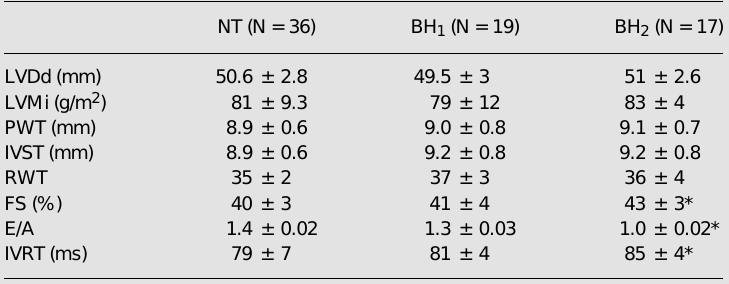
Table 4. Doppler echocardiographic values of normotensive (NT) and borderline hyper- tensive subjects with normal (BH 1 ) and elevated (BH 2 ) monitored blood pressure. NT (N = 36) BH 1 (N = 19) BH 2 (N = 17) LVDd (mm) 50.6 ± 2.8 49.5 ± 3 51 ± 2.6 LVMi (g/m 2 ) 81 ± 9.3 79 ± 12 83 ± 4 PWT (mm) 8.9 ± 0.6 9.0 ± 0.8 9.1 ± 0.7 IVST (mm) 8.9 ± 0.6 9.2 ± 0.8 9.2 ± 0.8 35 ± 2 FS (%) 40 ± 3 41 ± 4 43 ± 3* 1.4 ± 0.02 1.3 ± 0.03 1.0 ± 0.02* 79 ± 7 81 ± 4 85 ± 4* LVDd, left ventricular diastolic diameter; LVMi, left ventricular mass index; PWT, posterior wall thickness; IVST, interventricular septal thickness; RWT, relative wall thickness; FS, fractional shortening; E/A, early to late peak flow velocity ratio; IVRT, isovolumetric relaxation time. Values are reported as means ± SD.